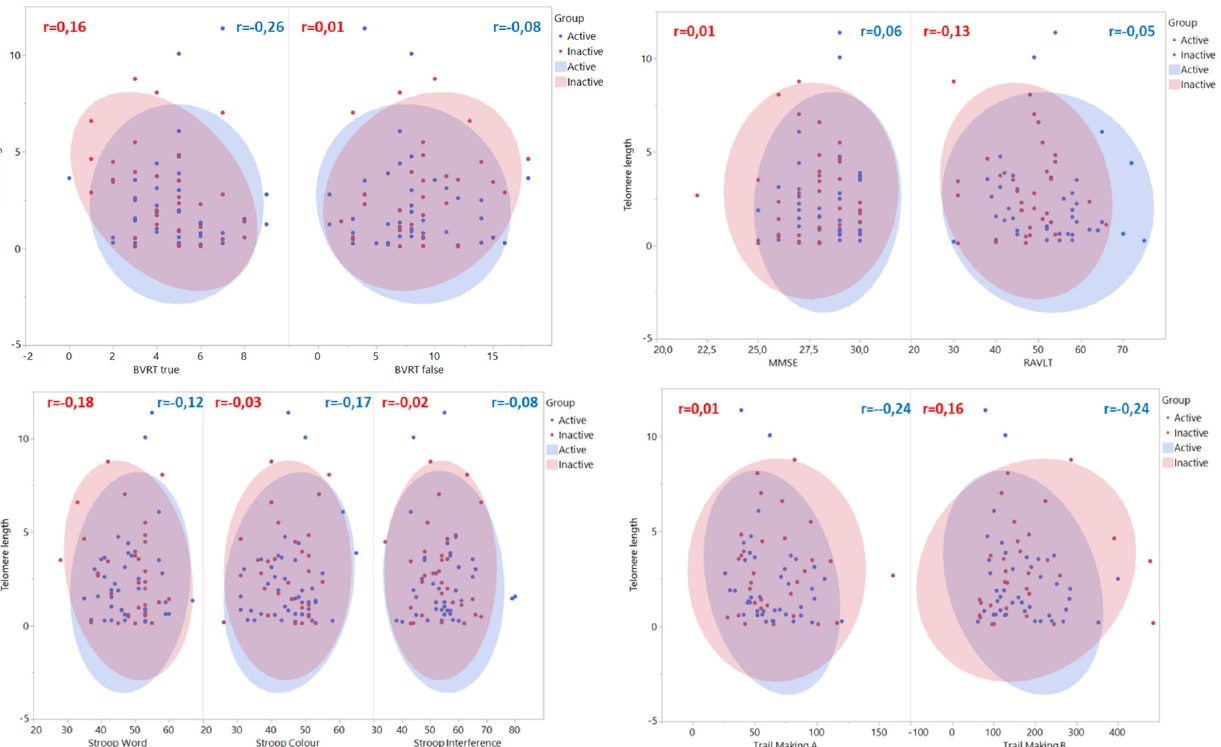
Figure 2. Scatterplot and correlation coefficients [r] from cognitive functions and length of telomere. The 95% bivariate normal density ellipse is shown in each scatterplot. This ellipse encloses approximately 95% of the points.